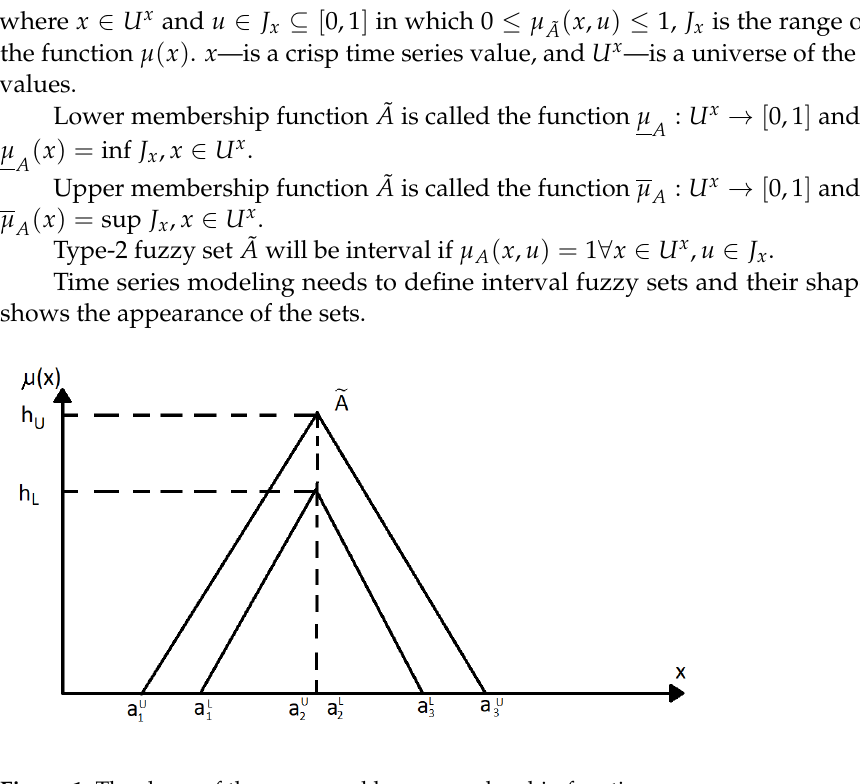
Figure 1. The shape of the upper and lower membership